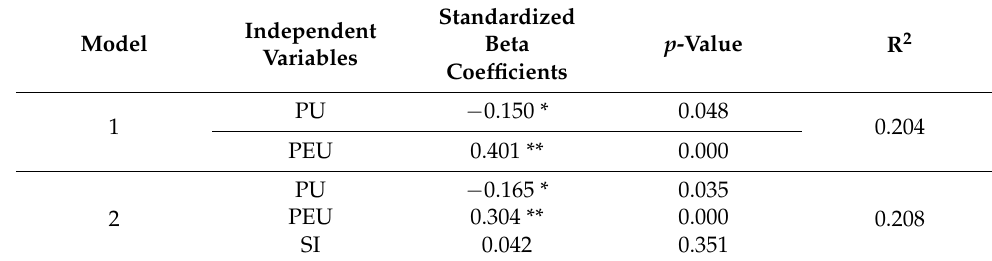
Table 5. Results of binary logistic regression models.